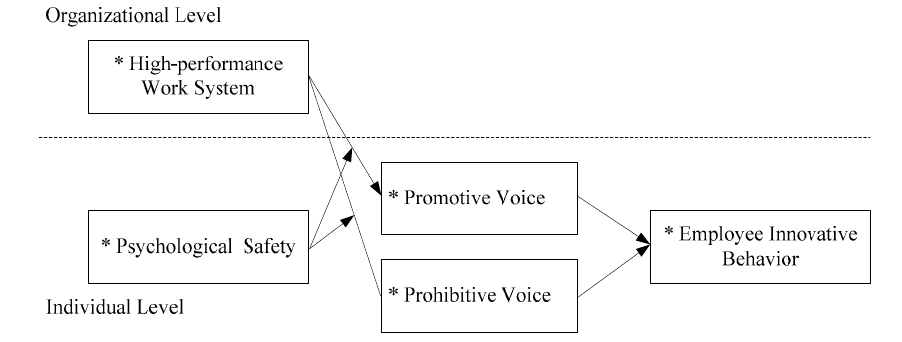
Figure 1. The conceptual multi-level model.